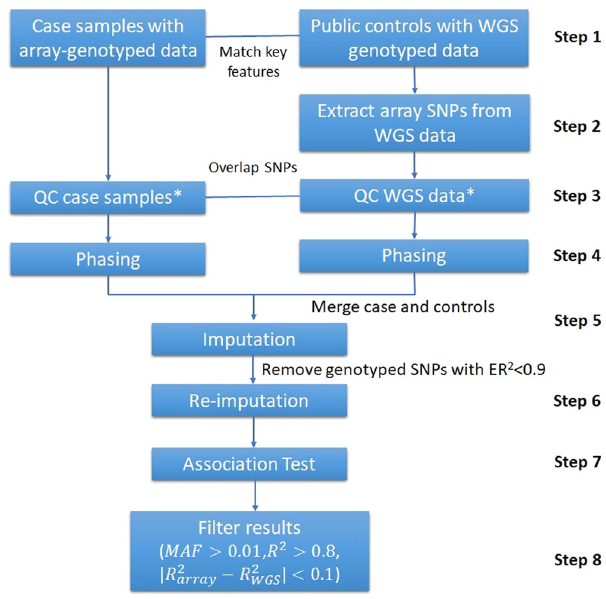
Fig. 1 Overview of the protocol to use whole-genome sequencing (WGS) data as public control in GWAS. *The quality control (QC) of the case and public control data is conducted independently according to the steps outlined in the